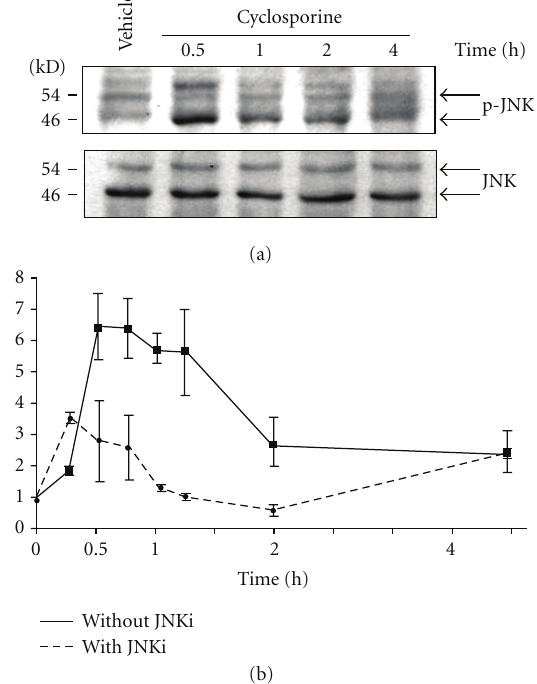
Figure 1: Cyclosporine (CsA) activates JNK signaling. (a) Repre- sentative western blot of JNK and p-JNK expression in primary cul- tures of HRECs exposed to the vehicle or 6 μ M CsA for various incubation times. (b) Real-time PCR analysis of EGR1 mRNA ex- pression in cells that were exposed to 6 μ M CsA with or without the 2 μ M JNK inhibitor